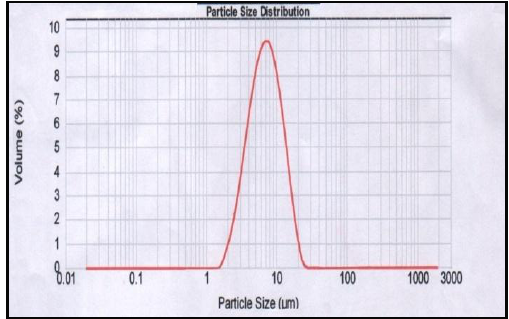
Figure 5: Particle size distribution of the F